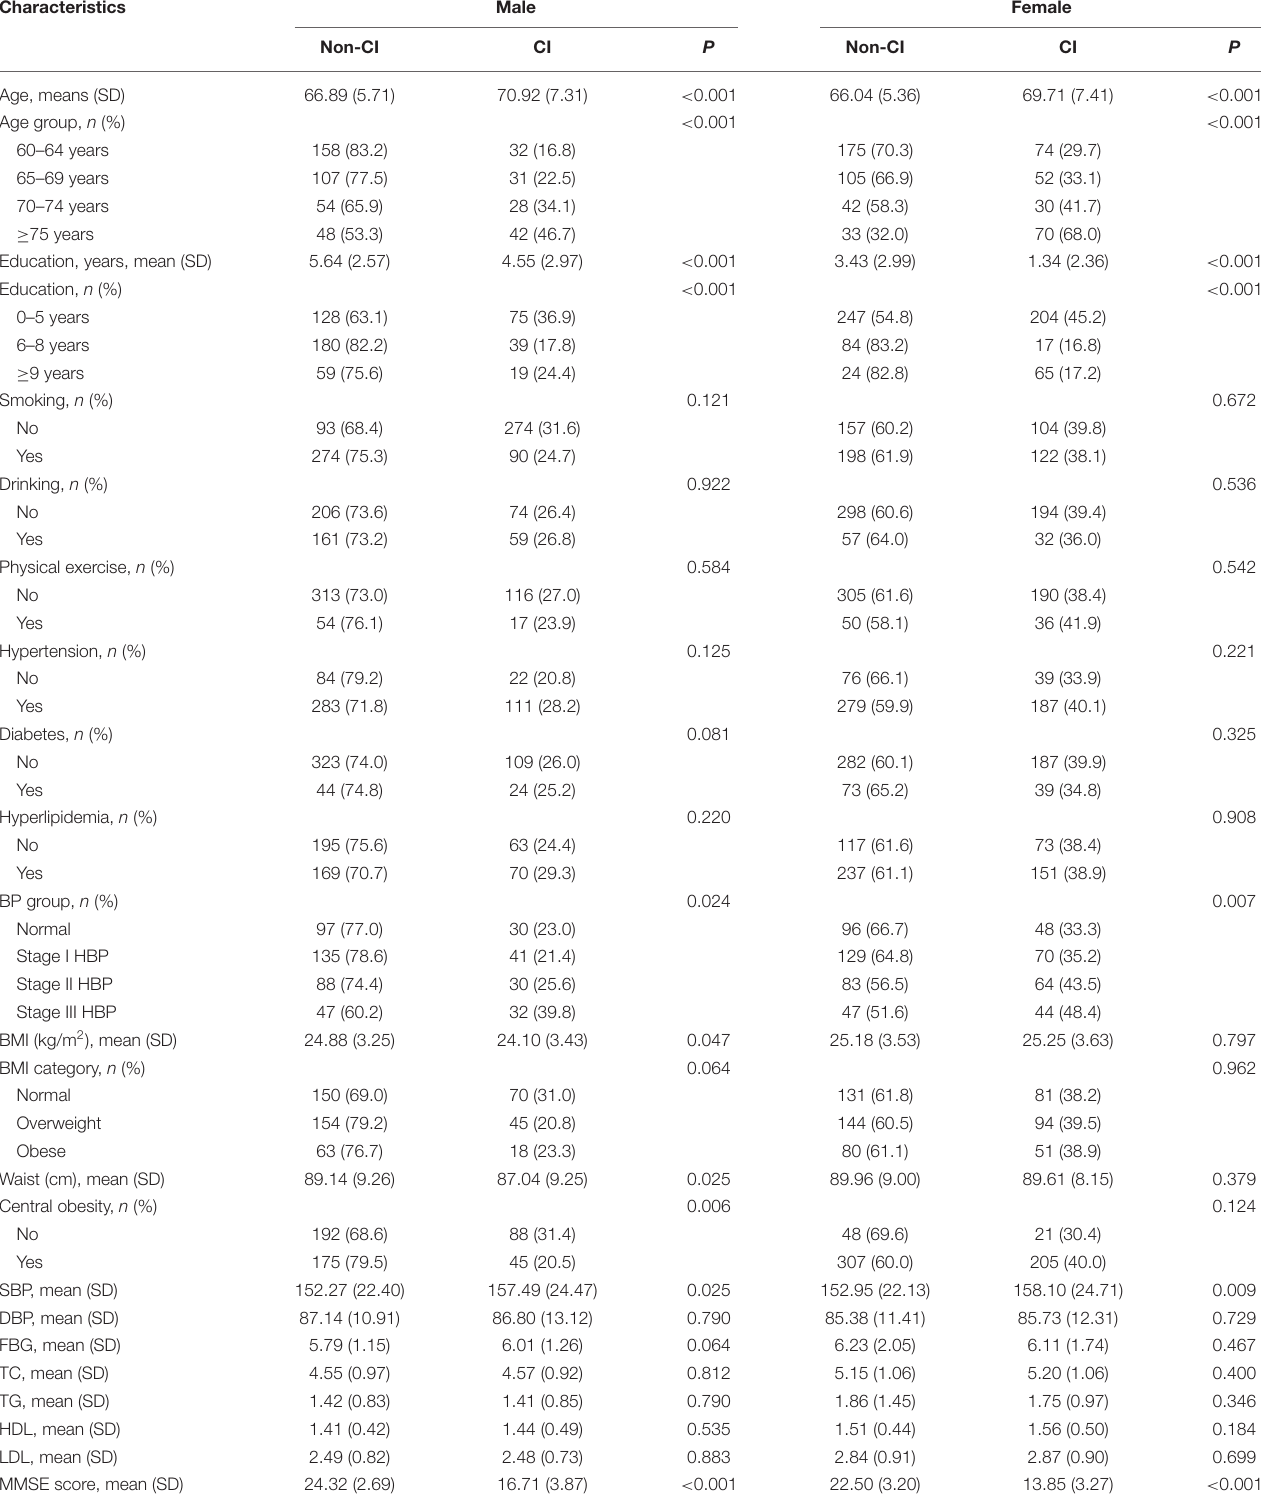
TABLE 2 | Association of cognitive impairment with demographic characteristics and risk factors by gender in univariate analysis.